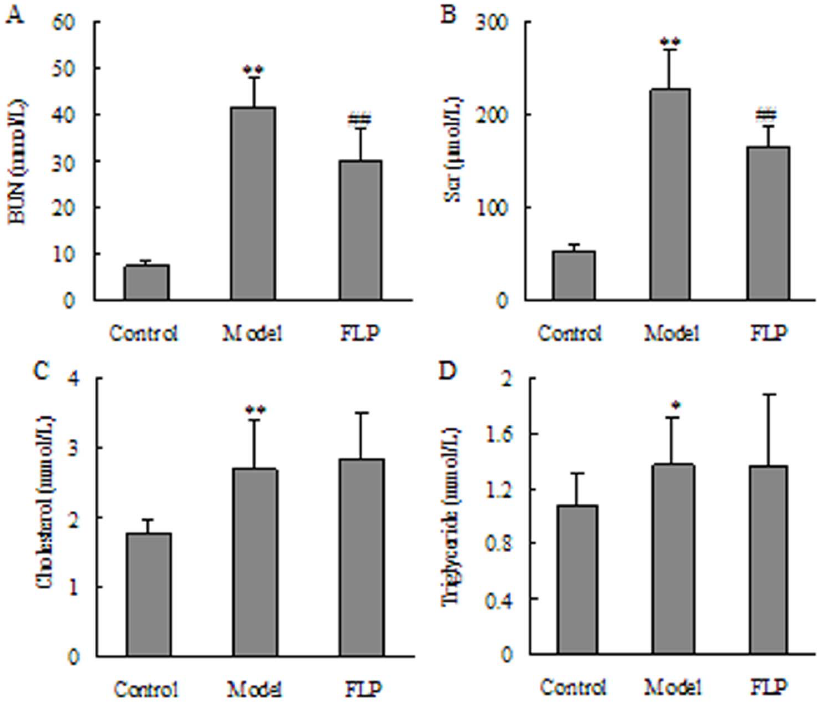
Figure 2. Basic serum biochemical parameter comparisons among the studied groups. (A) BUN; (B) Scr; (C) cholesterol; (D) triglyceride. The data were expressed as mean 6 SD. * P , 0.05, ** P , 0.01 compared to the control groups and # P , 0.05, ## P , 0.01 compared to the CKD groups.